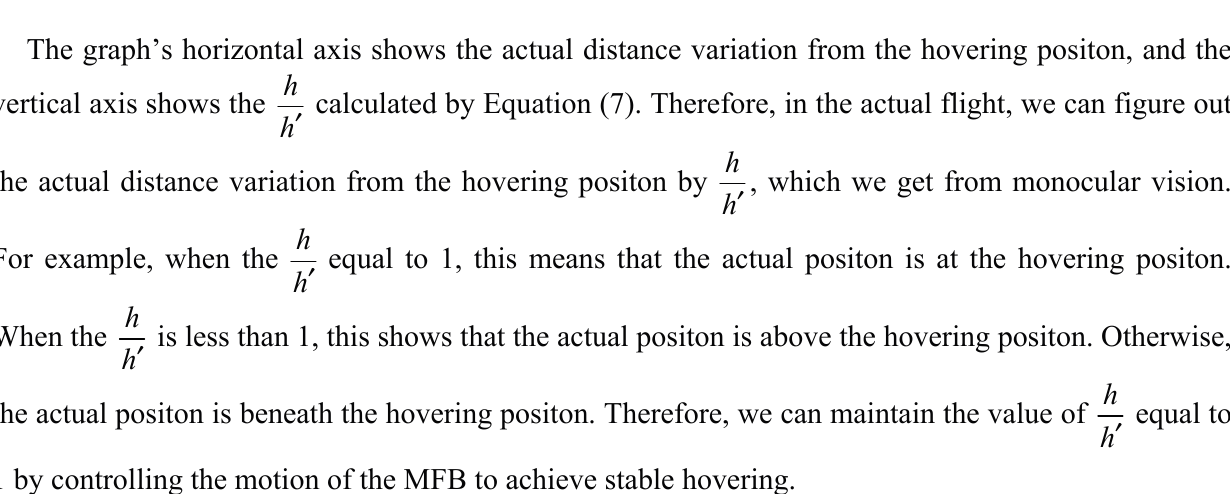
Figure 10. The relation of actual displacement and the measured